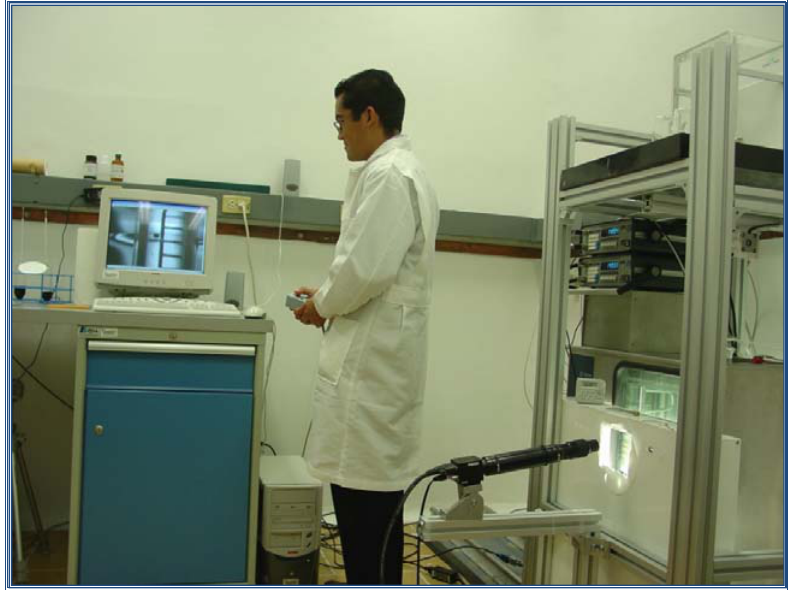
Figure 10. Calibration using the vision